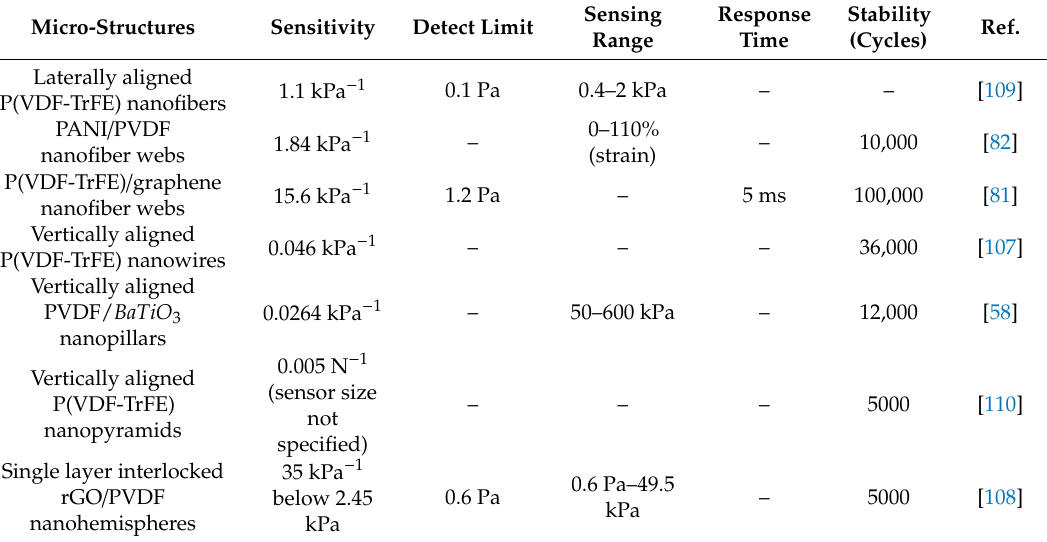
Table 1. Comparison of piezoelectric sensors with di ff erent